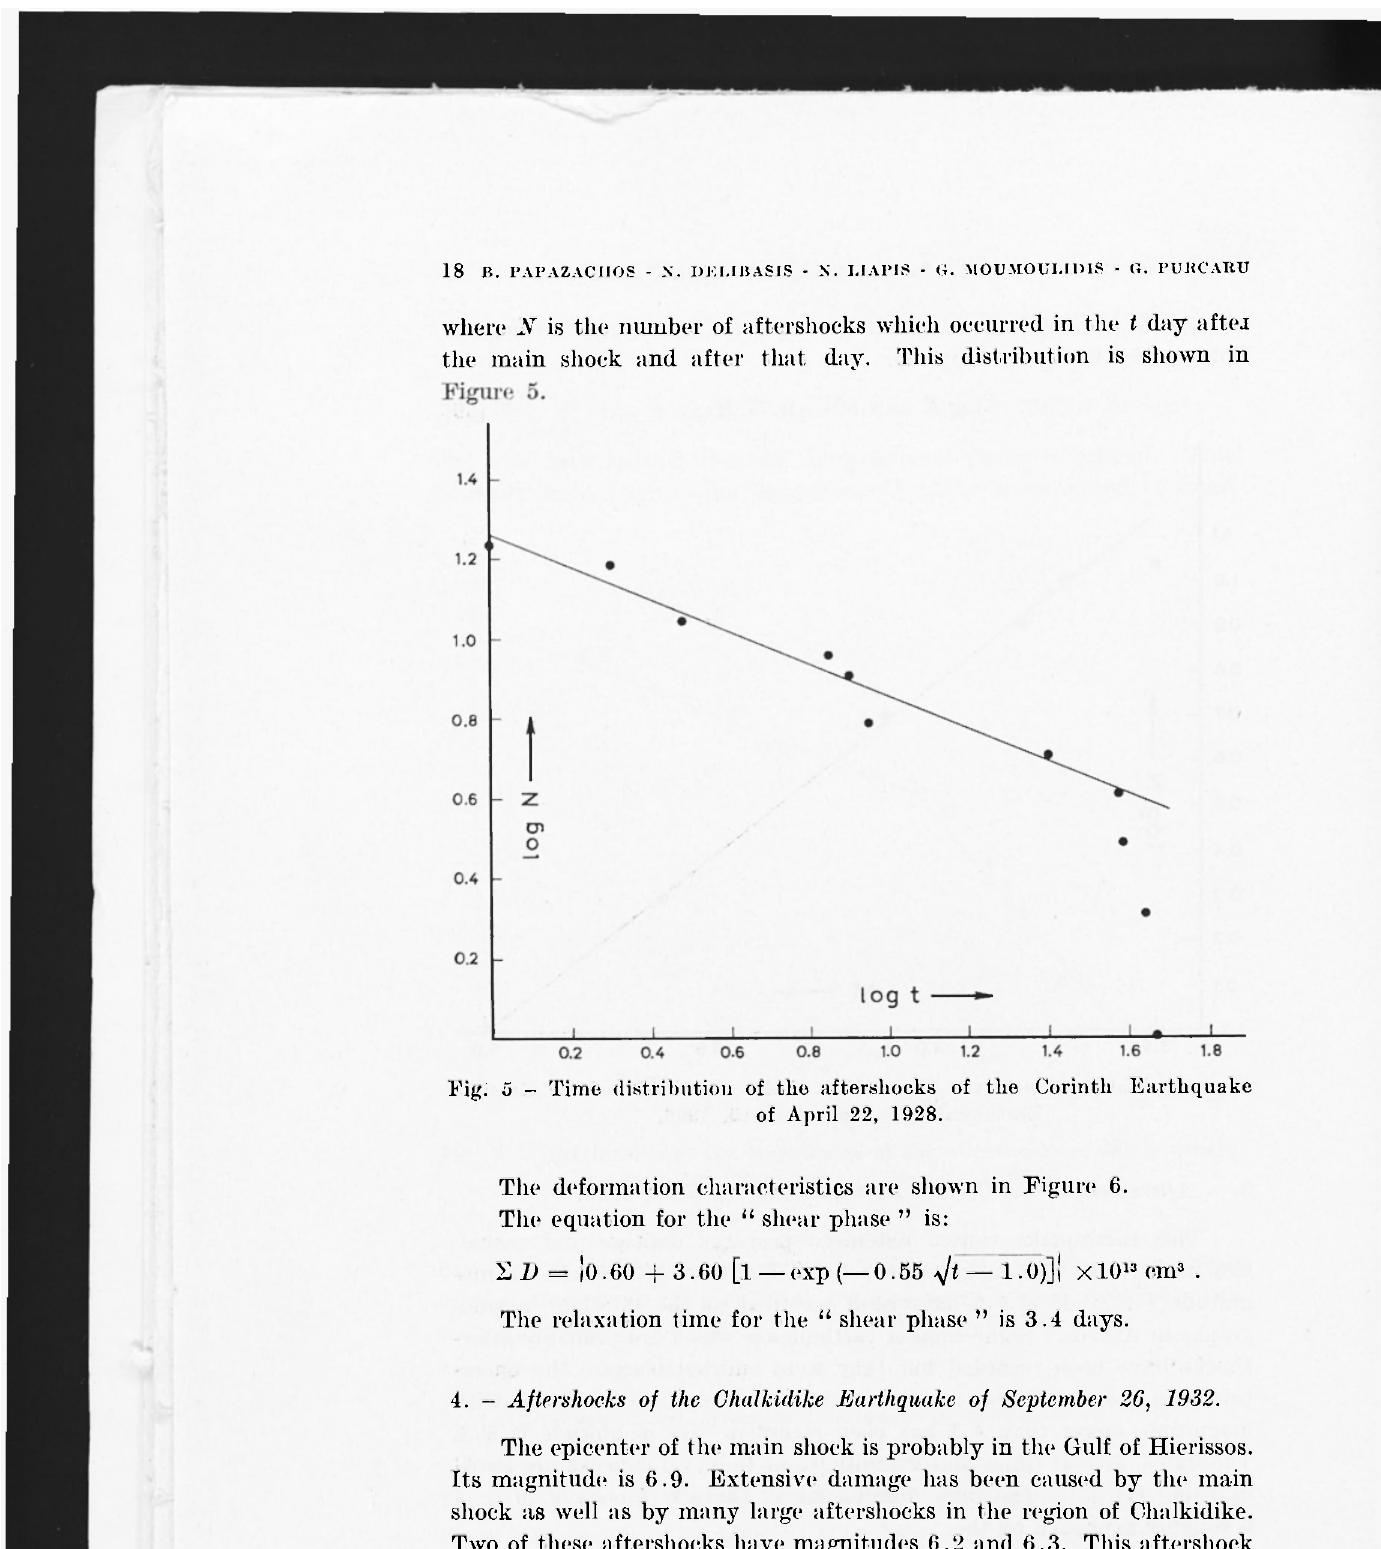
Fig: 5 - Time distribution of the aftershocks of the Corinth Earthquake of April 22,